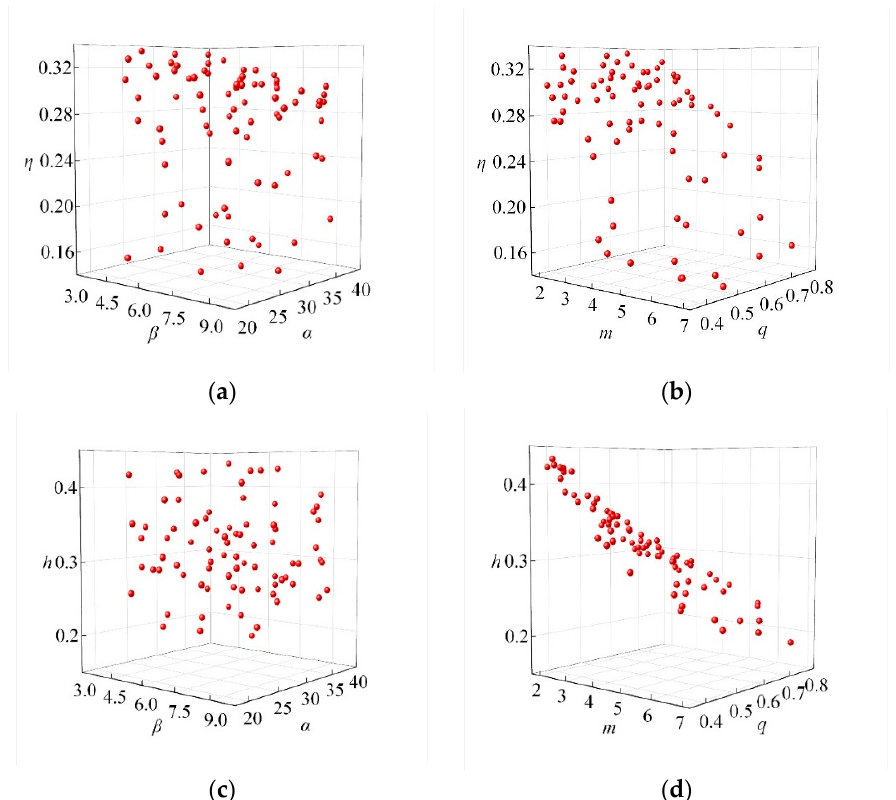
Figure 7. Performance of different sampling points. ( a ) η corresponding to α and β ; ( b ) η corresponding to m and q; ( c ) h corresponding to α and β ; ( d ) h corresponding to m and q.